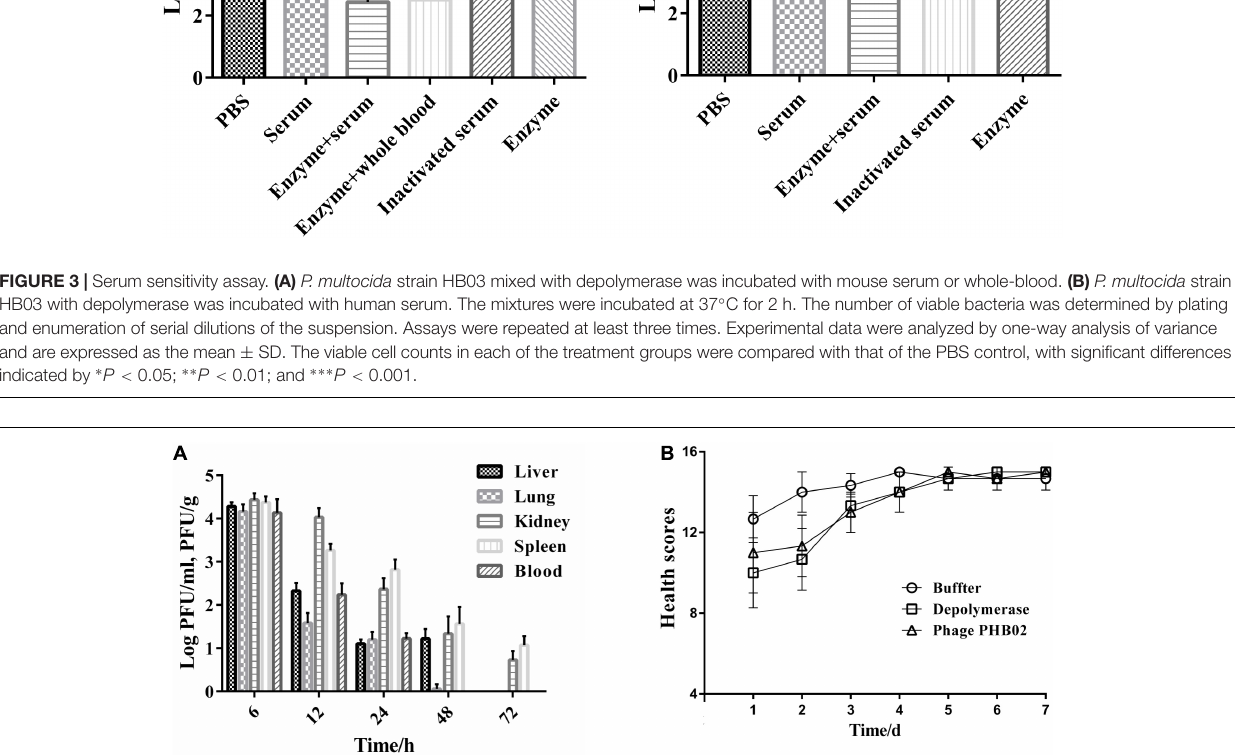
FIGURE 4 | In vivo assays. (A) Distribution of phage PHB02 in mice. The experiment was repeated three times and results are expressed as the mean ± SD. (B) Scores of clinical symptoms post-challenge. The health status of each group of mice was given a score between zero and five, as follows: five: normal health, condition unremarkable; four: decreased physical activity and ruffled fur; three: lethargy and hunched back; two: exudative accumulation around partially closed eyes; one: near death; zero: dead. The total score for each group was recorded at least three times per day. The data are expressed as the mean ±